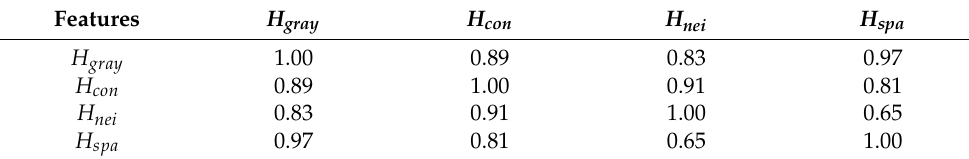
Figure 10. Changes in image information content at different features during downsampling. The scatter plots image(a),(b) and (c) show the trend of multi-feature information content of three GID high-resolution remote sensing images (a), (b) and (c) during the downsampling process. Table 1. Spearman correlations of the information content of each feature in downsampled images. Features